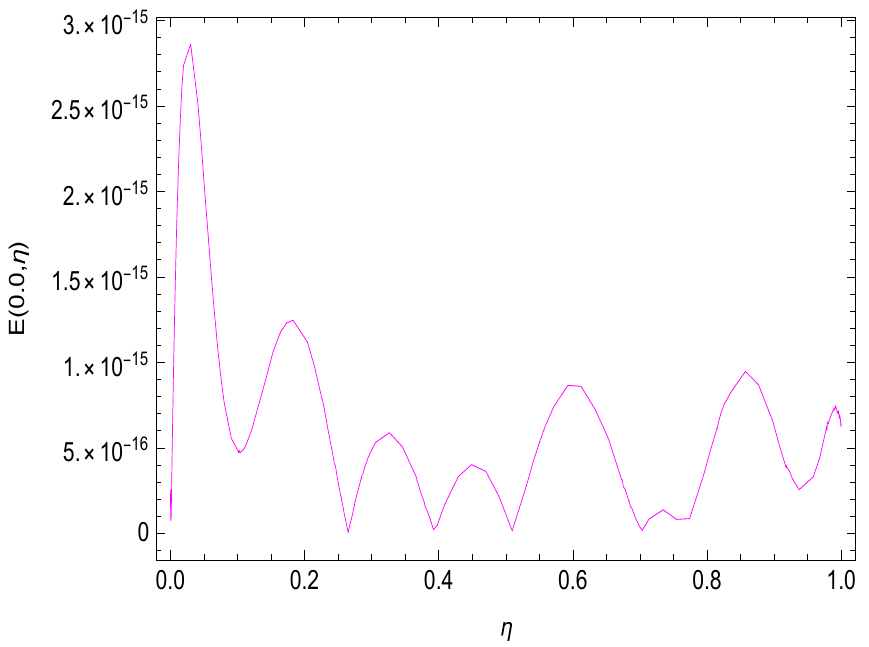
Figure 4. η -absolute errors of the problem (17), where ε = 1.7, ν = 0.9 and N = M = K = 10.